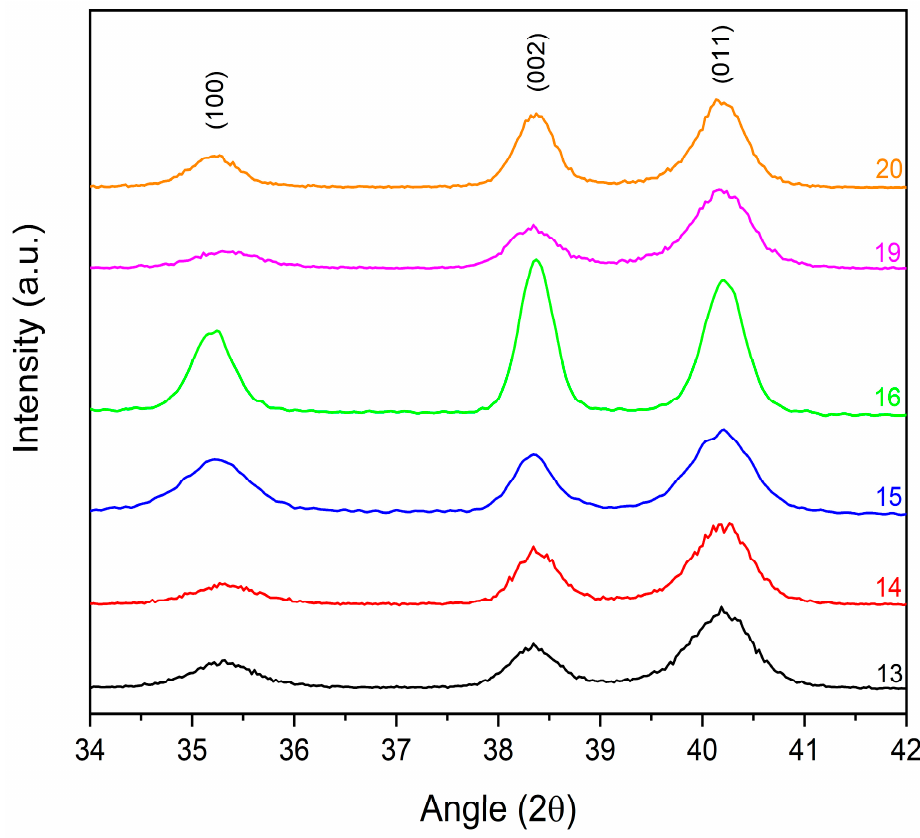
Figure 9. Peak intensity of α′ (011) and α″ (002) as a function of deposited Nb. Different results were obtained with samples of set II. A higher applied voltage and number of pulses promoted the melting and the interdiffusion of Nb and Ti, with the formation of an α′ hcp Ti–Nb alloy (Figure 10). Lattice parameters of the α′ hcp and cell volume ( V = a 2 csen 60 ◦ ) were calculated from the XRD reflections in a Bragg–Brentano configuration and are listed in Table 7 for all samples with hcp structure.